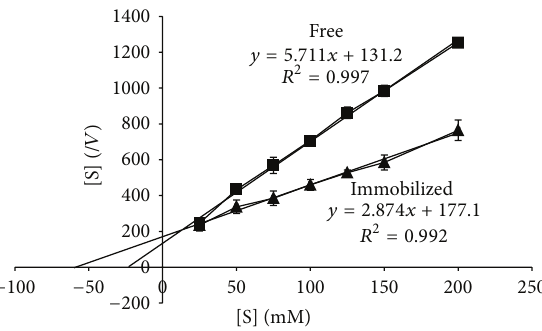
Figure 5: Kinetic parameters of free and immobilized 𝛽 - galactosidase using the Hanes-Woolf plot method.